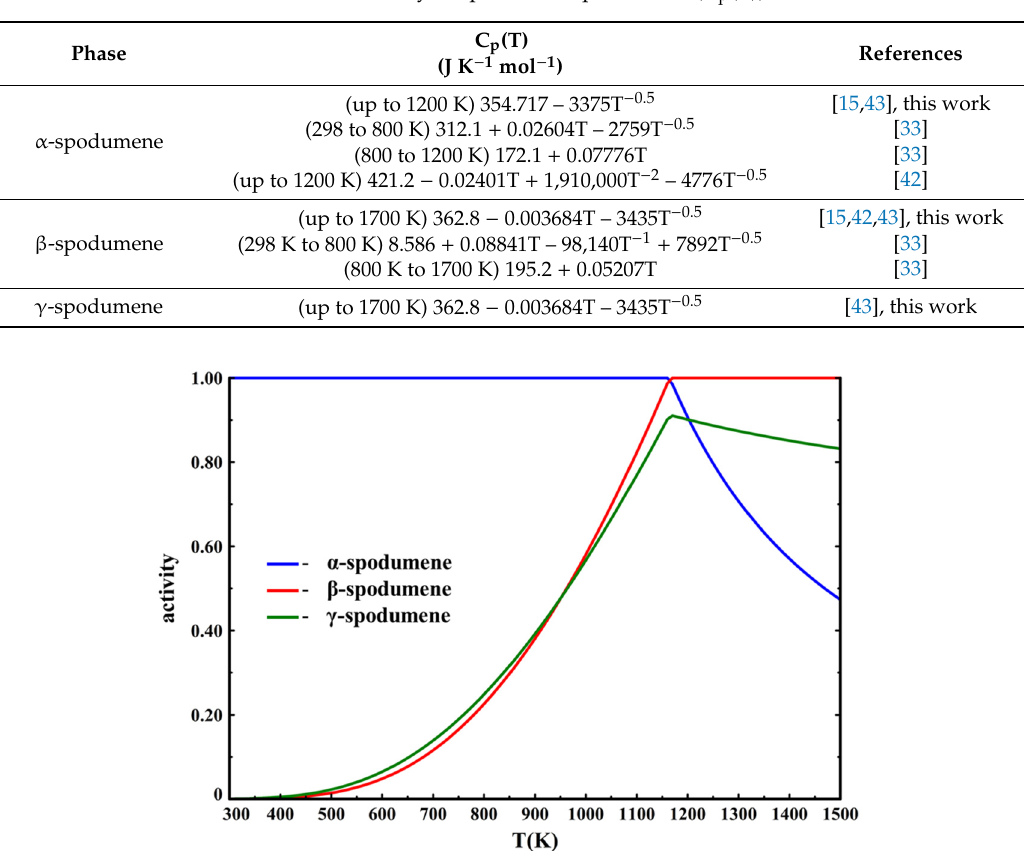
Table 8. Summary of spodumene phase data ( C p (T)).